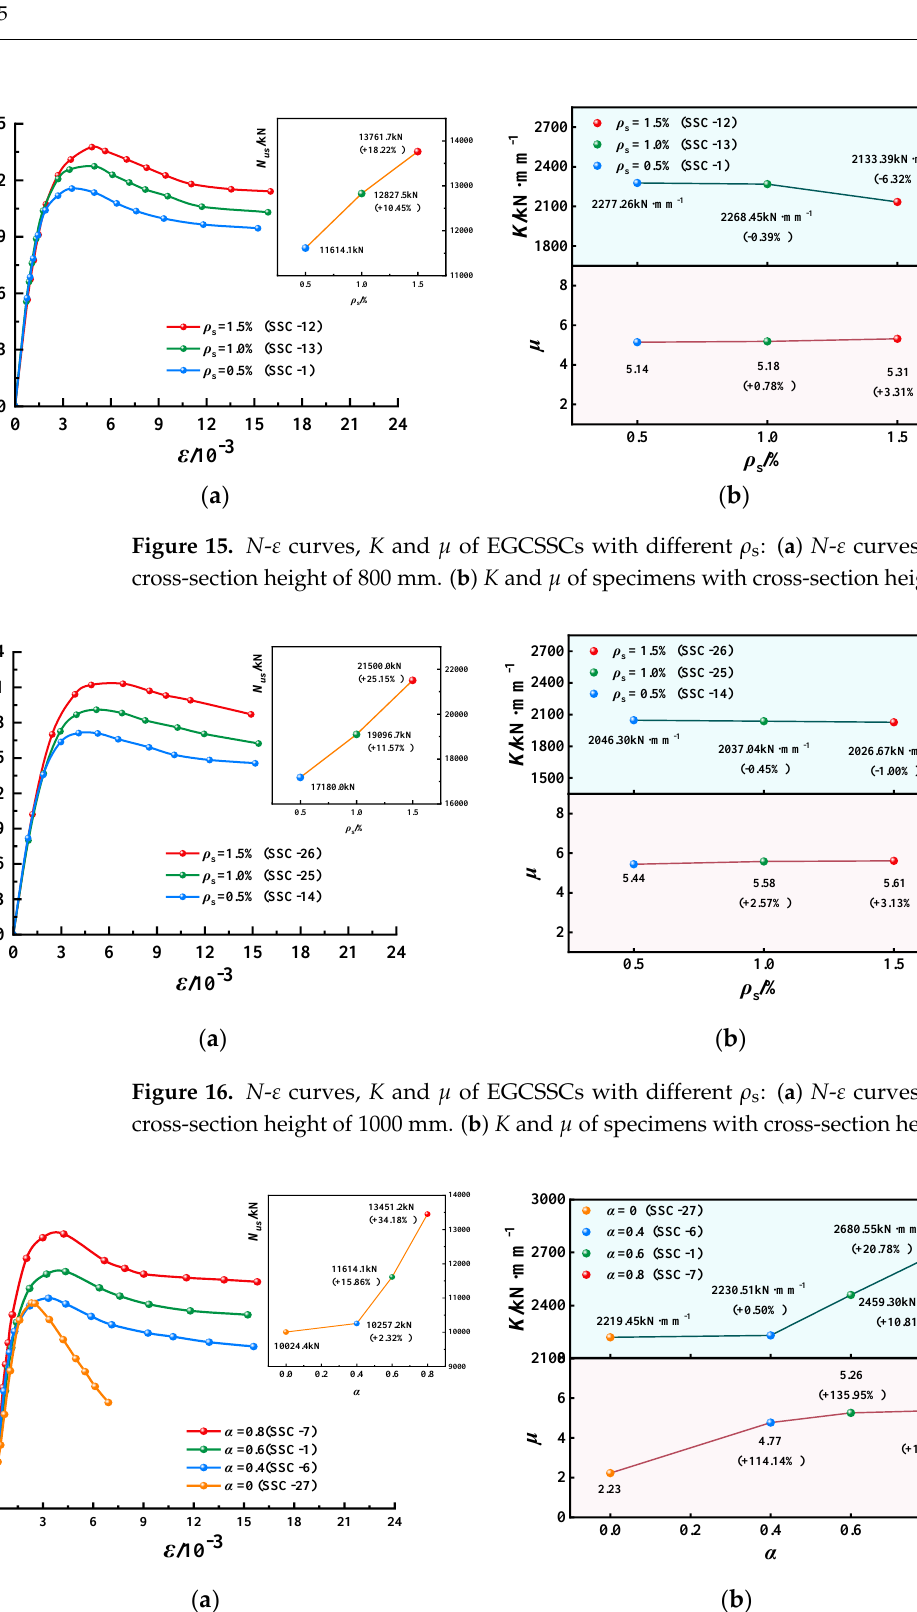
( b ) Figure 18. N - ε curves, K and µ of EGCSSCs with different α : ( a ) N - ε curves of specimens with cross-section height of 1000 mm. ( b ) K and µ of specimens with cross-section height of 1000 mm. ( a )